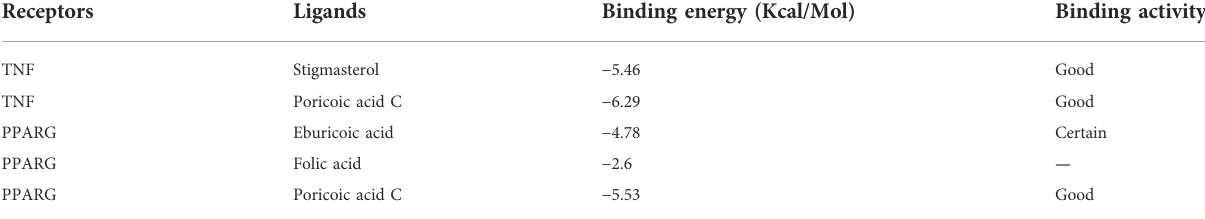
TABLE 2 DSS molecular docking binding enery results.